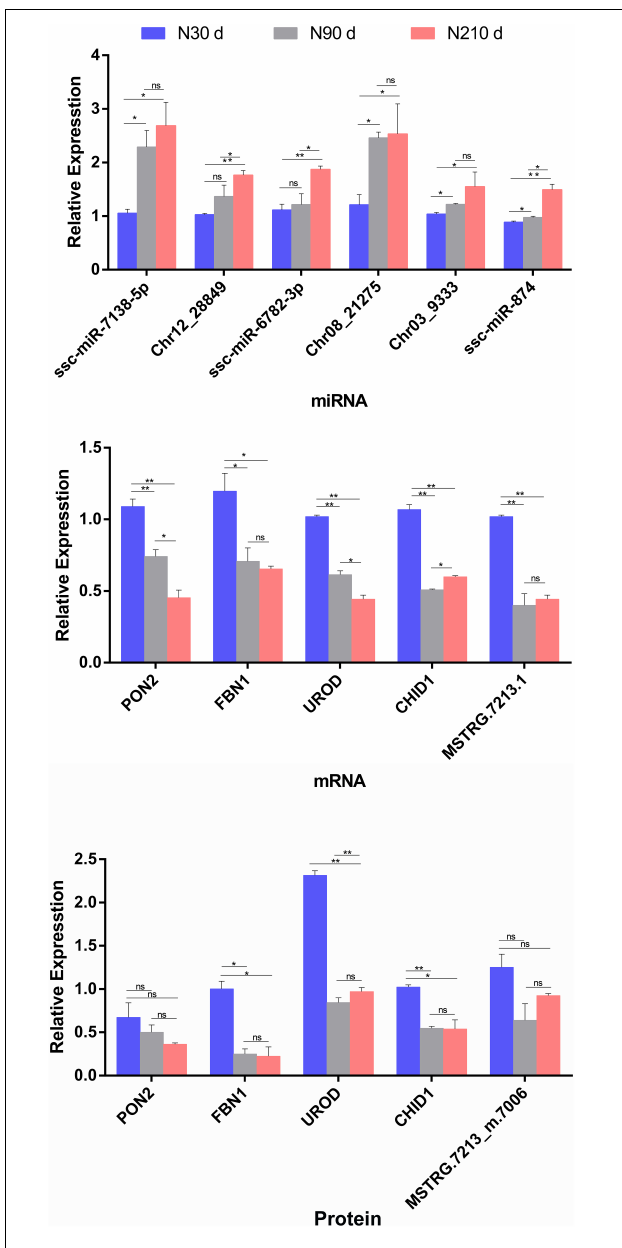
FIGURE 8 | Relative miRNA/mRNA/protein expression of seven selected miRNA–mRNA–protein interaction pairs for comparison of three time periods (30, 90, and 210 days), in respect to miRNAome/transcriptome and qRT-PCR, or proteome and parallel reaction monitoring (PRM). The histograms represent the result of qRT-PCR/PRM verification. Data are represented as mean ± SEM, n = 3 per group. * P < 0.05, ** P <